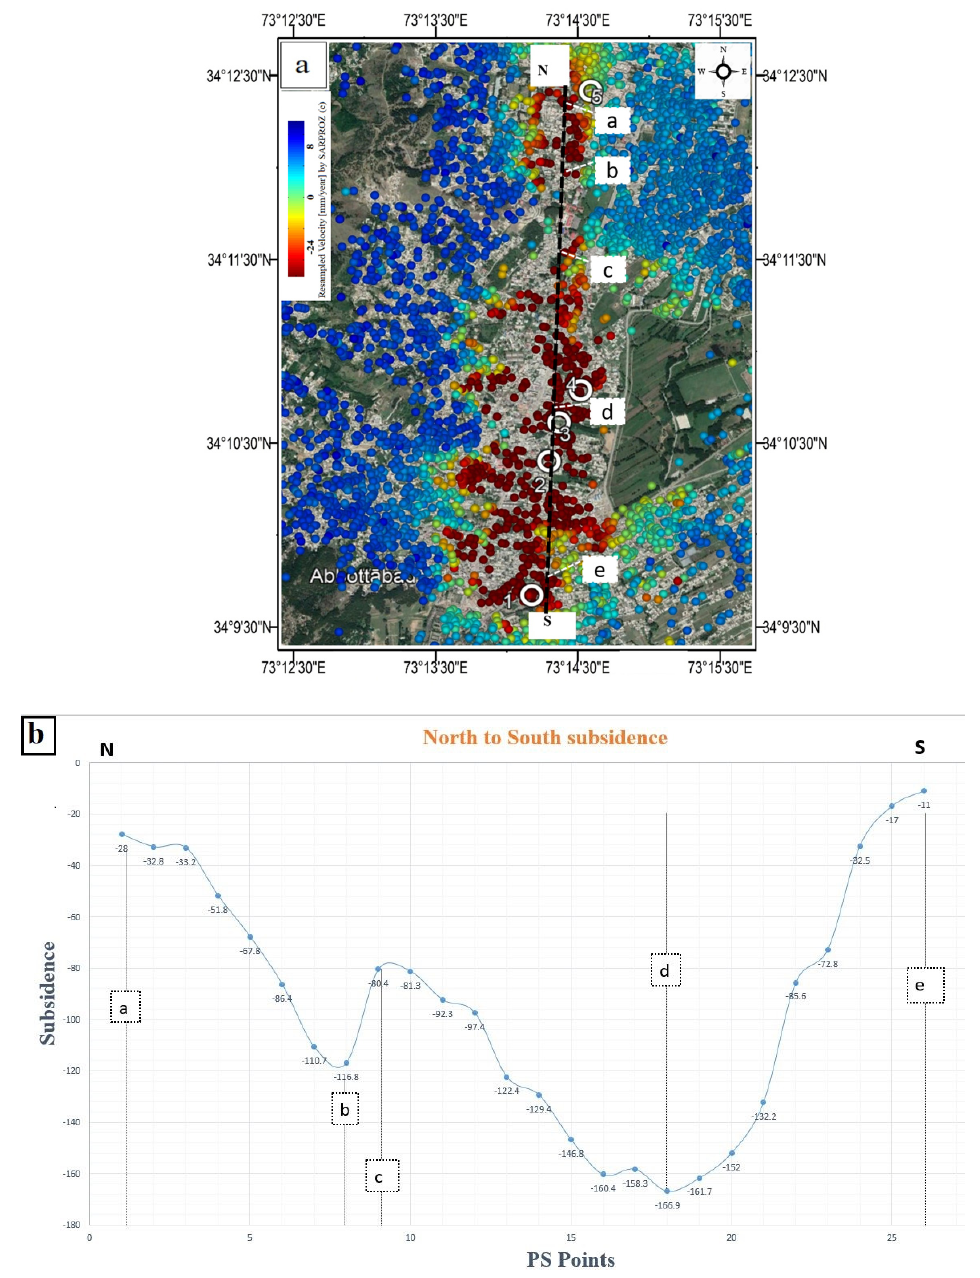
Figure 12. ( a ) Subsidence profile from north to south; ( b ) north–south subsidence trend graph (2017–2019). In Figure 12a the black line represents the north–south subsidence profile, where (a), (b), (c), (d), and (e) highlight subsidence at these specific points. Figure 12b represents a subsidence fluctuation graph of the north–south subsidence profile (x-axis represent PS points, y-axis represent subsidence). In Figure 12b the (a), (b), (c), (d), and (e) mark sub- sidence at the corresponding specific points, as shown in Figure 12a.